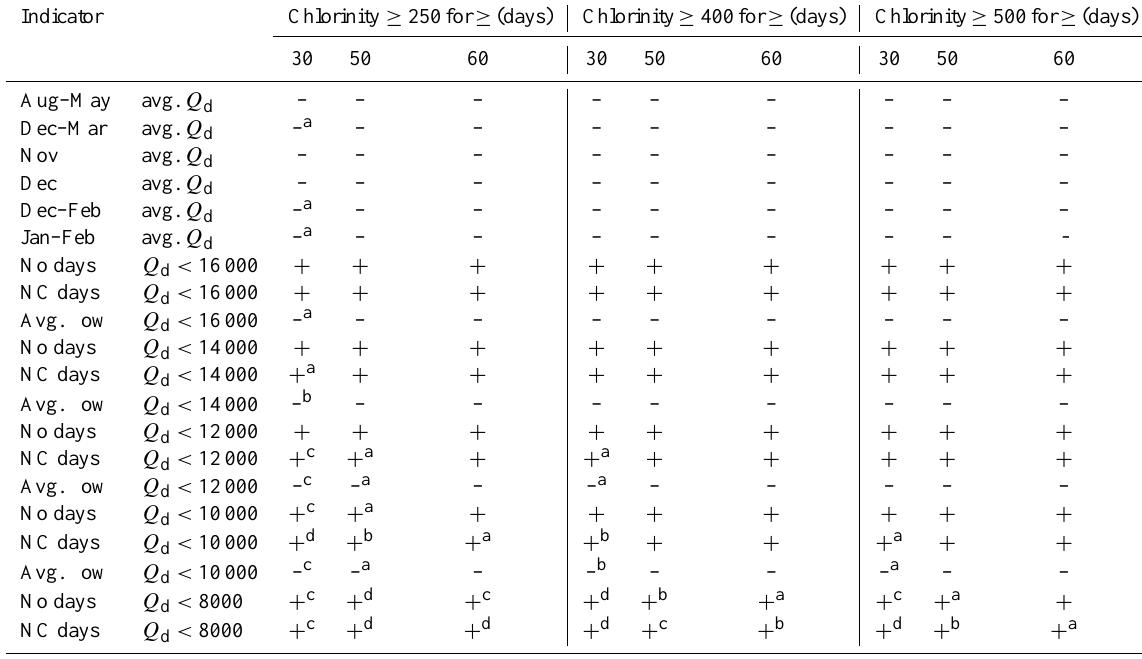
Table 2. Correlations between probabilities of chlorinity above stated levels for stated lengths of time and selected discharge characteristics, annual